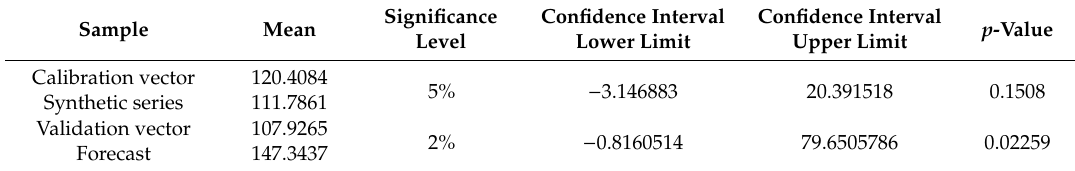
Table 2. Hypothesis test regarding the di ff erence between the two means from the Momil